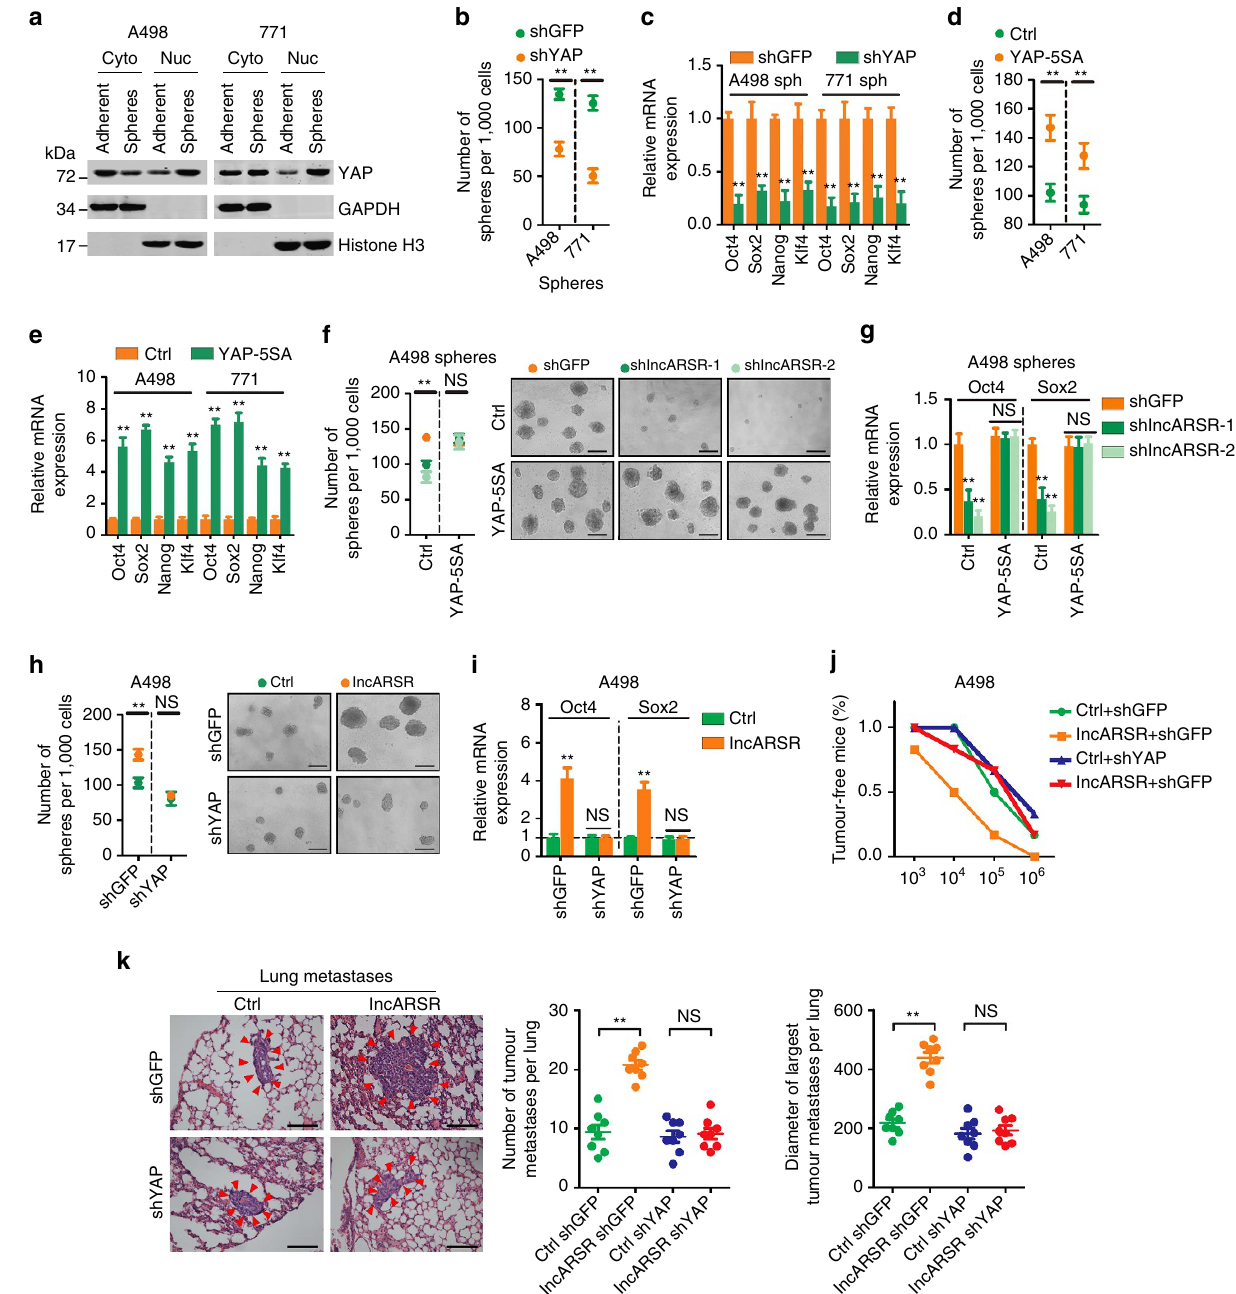
Figure 5 | YAP is responsible for lncARSR-mediated T-IC properties. ( a ) Western blot analysis of YAP in subcellular fractions of RCC adherent and sphere cells. GAPDH and Histone H3 acted as cytoplasm and nucleus marker, respectively. ( b ) Spheres formation assay of YAP-knockdown and control RCC spheres ( n ¼ 3). The number of spheres was counted after 7 days. ( c ) qRT–PCR analysis of indicated mRNAs in YAP-knockdown and control